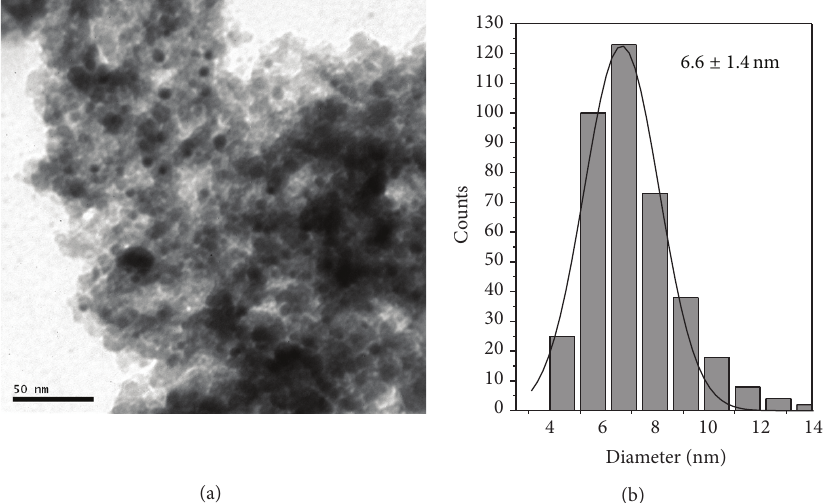
Figure 3: (a) TEM micrographs showing the Pd(0) nanoparticles to Pd(0)/SiO 2 /HF observed at 120kV. (b) Histogram illustrating the particle size